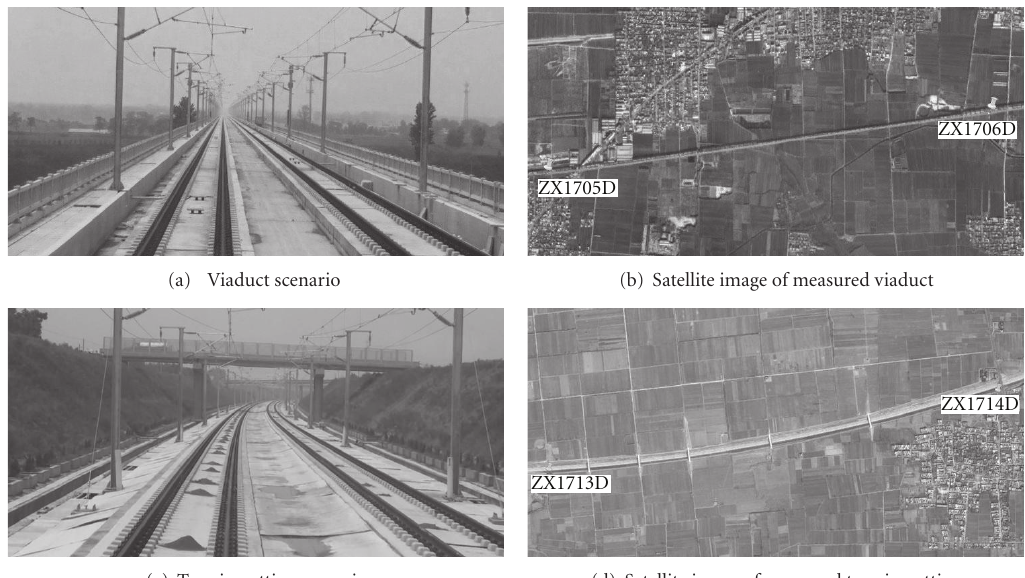
Figure 2: Measurement